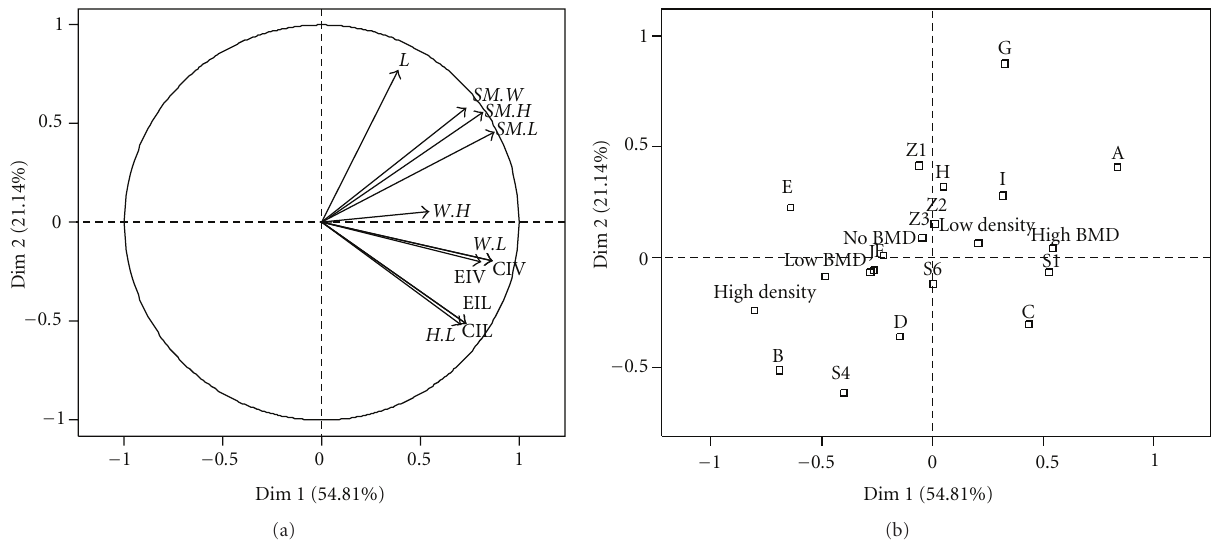
Figure 4: NPCA on morphometric variables (individuals and variables graphs) with strata, density, and BMD as supplementary